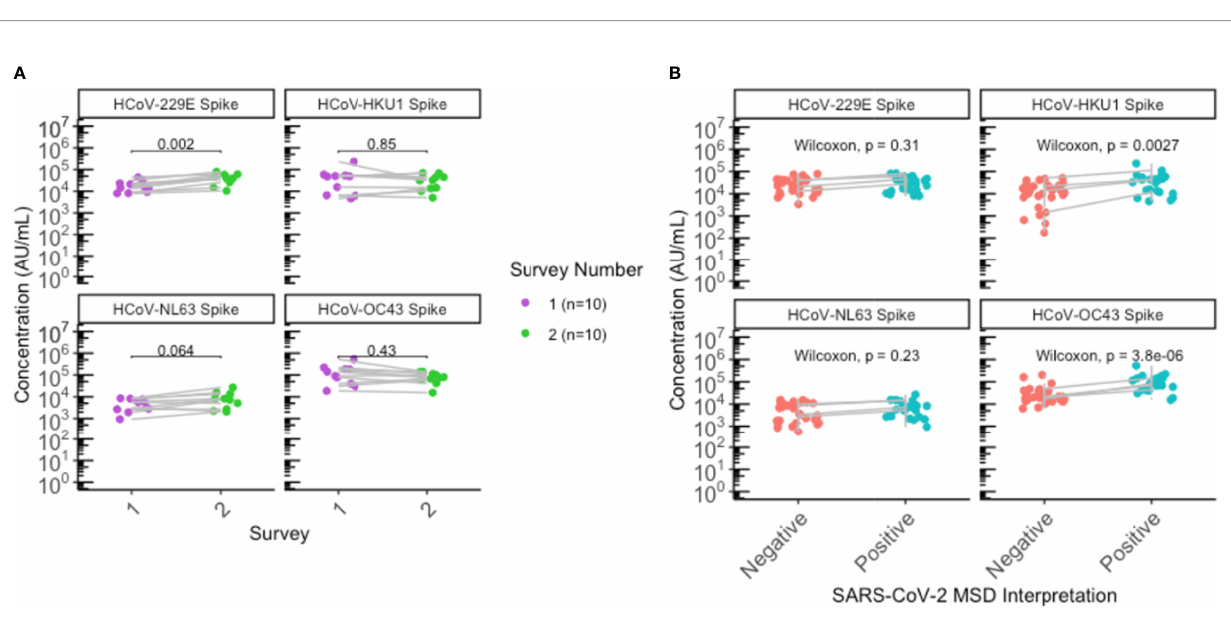
FIGURE 2 | Signi fi cant elevation of HKU1 and OC43 antibodies in SARS-CoV-2 positive individuals. (A) HCoV antibody levels of residents that were seropositive during the fi rst survey (N=10) were plotted according to the fi rst (purple) and second (green) sero-surveys. (B) Antibody levels for all residents with paired sera collected (N=26) were plotted by SARS-CoV-2 negative (red) or positive (blue) status to assess antibody levels to endemic HCoV. Grey lines indicate paired samples collected from the same individual from both surveys, and lines on (A, B) traversing across negative (red) to positive (blue) indicate seroconversion, while vertical lines indicate that the individual ’ s paired serum samples both remained seronegative or seropositive across the two surveys. (A, B) Statistical analysis was performed using (A) Wilcoxon signed-rank test and (B) Wilcoxon rank-sum test.